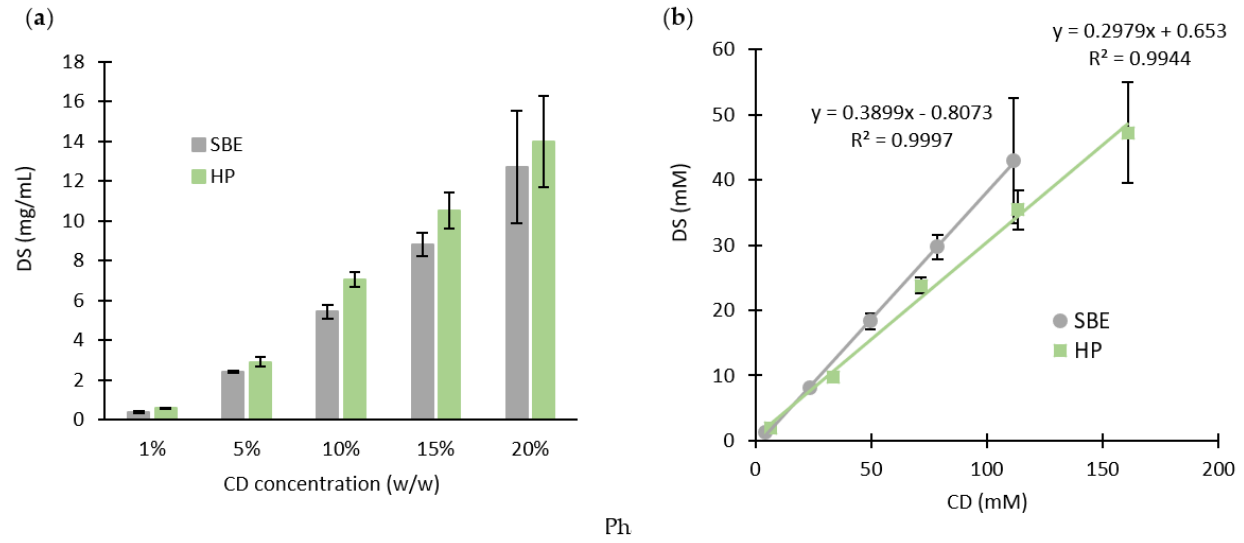
Figure 3. ( a ) DS solubility in assorted CD solutions; ( b ) phase solubility diagrams of DS and CD (mean ± SD, n = 3).